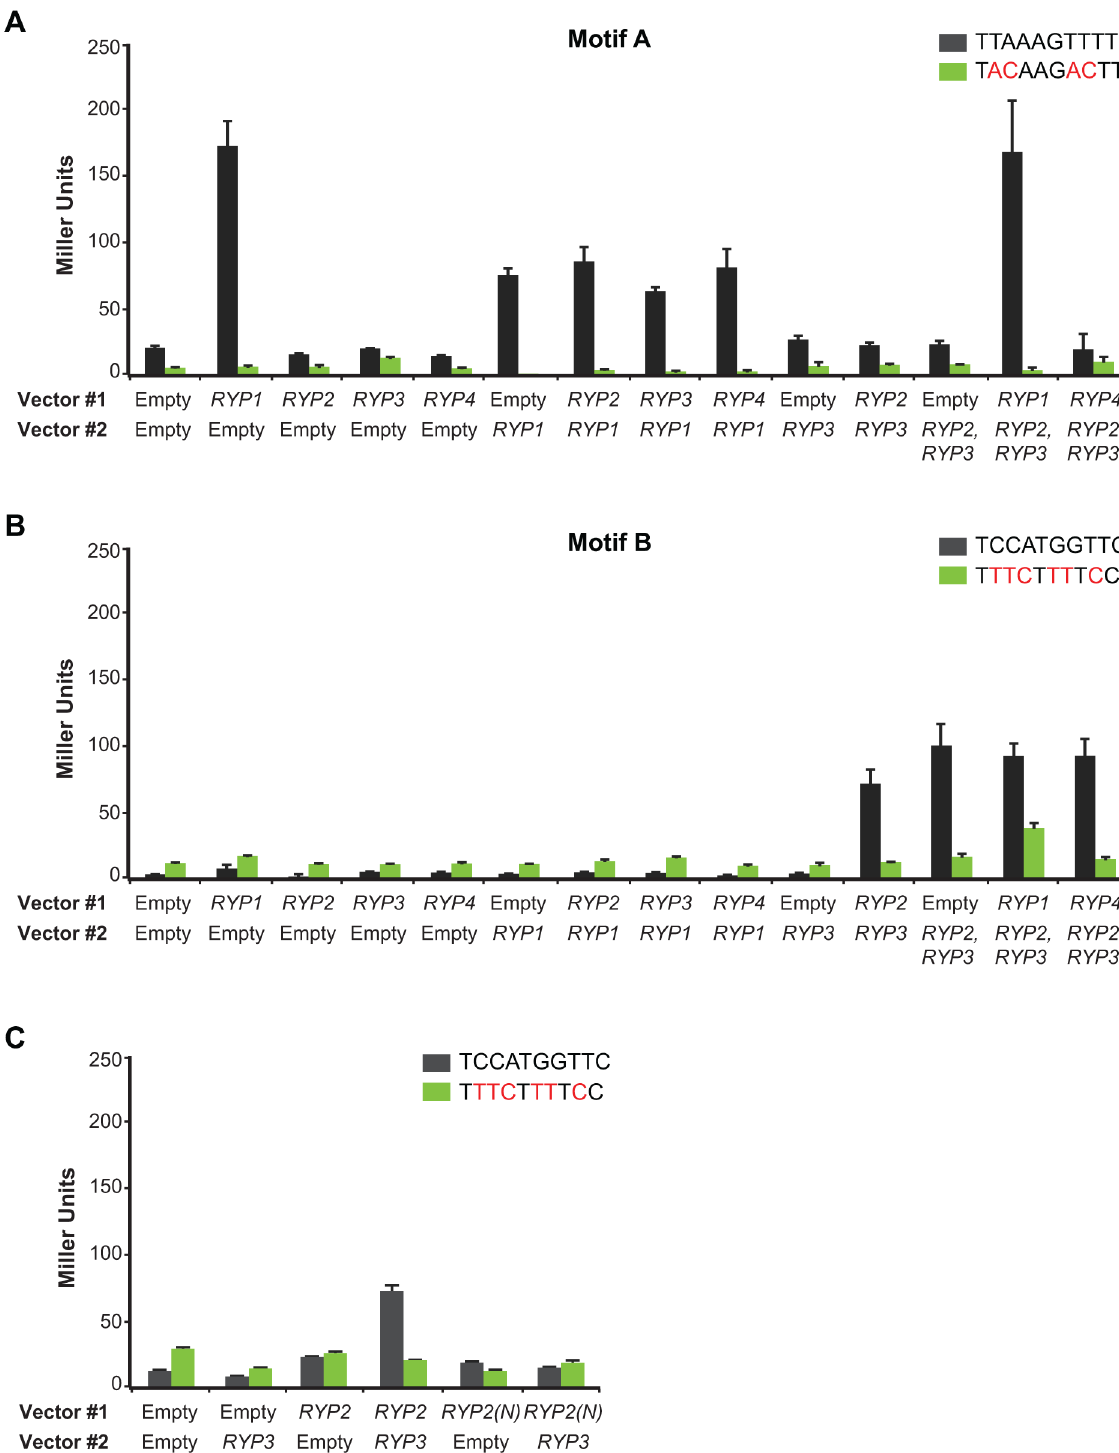
Figure 7. Ryp factors can drive gene expression using specific cis -acting regulatory elements. (A) Motif A (B, C) Motif B, and their mutated versions were cloned into UAS-less CYC1 promoter fused to lacZ gene. Point mutations made in the motifs are shown in red. RYP genes were cloned into two different vectors with two different markers. Each of these vectors were transformed into motif-containing yeast strains as labeled. b - galactosidase activities were measured for three independent isolates of each strain. Quadruplicate measurements of representative isolates are graphed as mean 6 standard deviation.